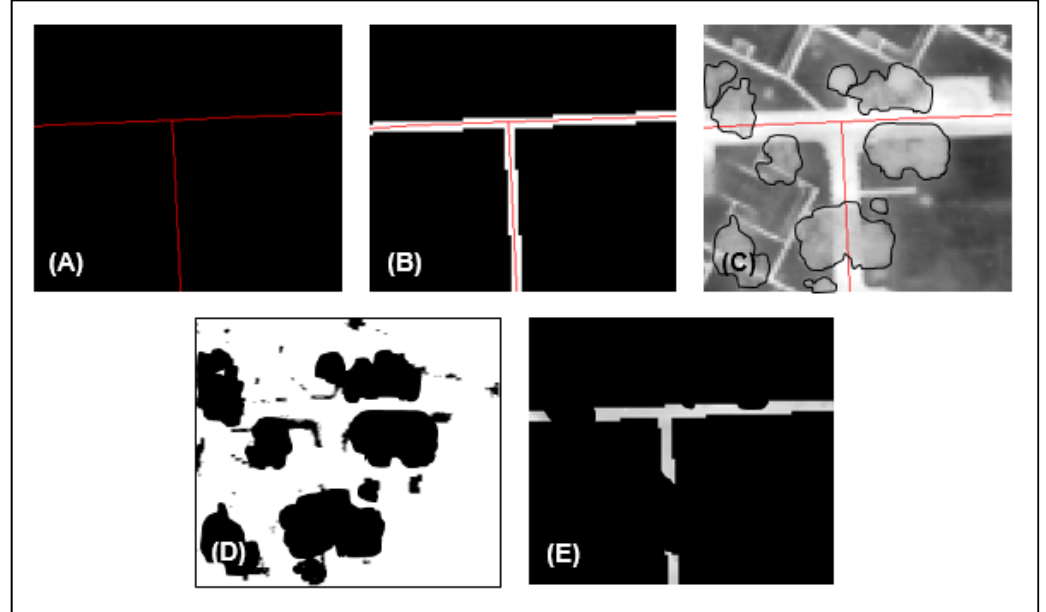
Figure 3. An example of the Road extraction technique. ( A ) The GIS Road layer (red). ( B ) The 1.5 m buffer created on both sides of the Road center ( i.e. , Road mask in white). ( C ) The TIR image showing dark tones as cool objects and bright tones as hot objects. Vegetation is delineated with black polygons (for illustration only) and the Road center as a red line. ( D ) The dilated vegetation mask created from an NDVI image where black areas represent vegetation. ( E ) A ‘vegetation-free’ 3.0 m wide TIR Road mask filled with thermal